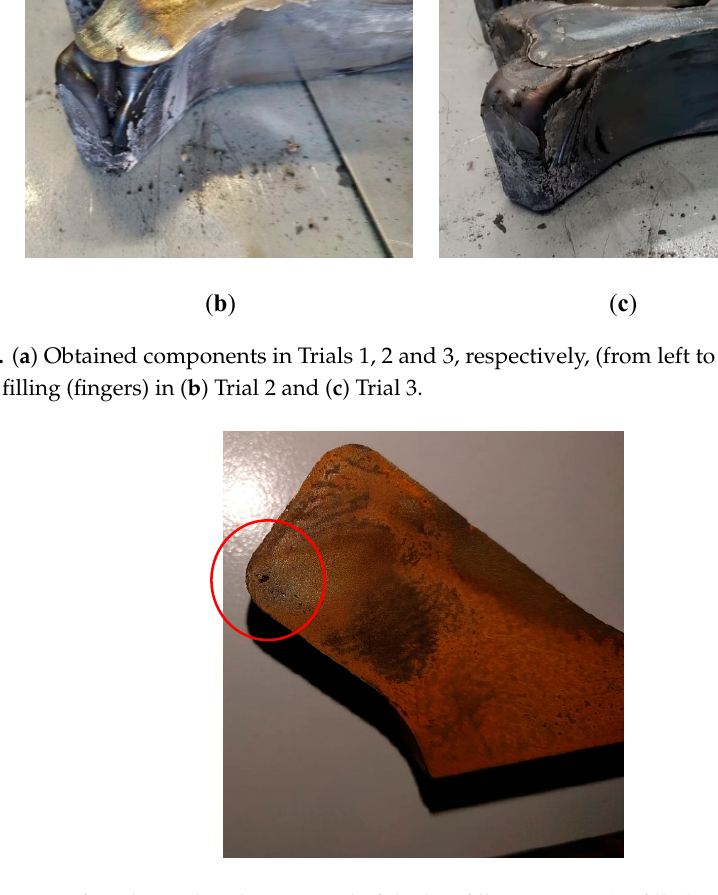
Figure 9. Defects located at the very end of the last filling regions (unfilled regions) of Trial 3.